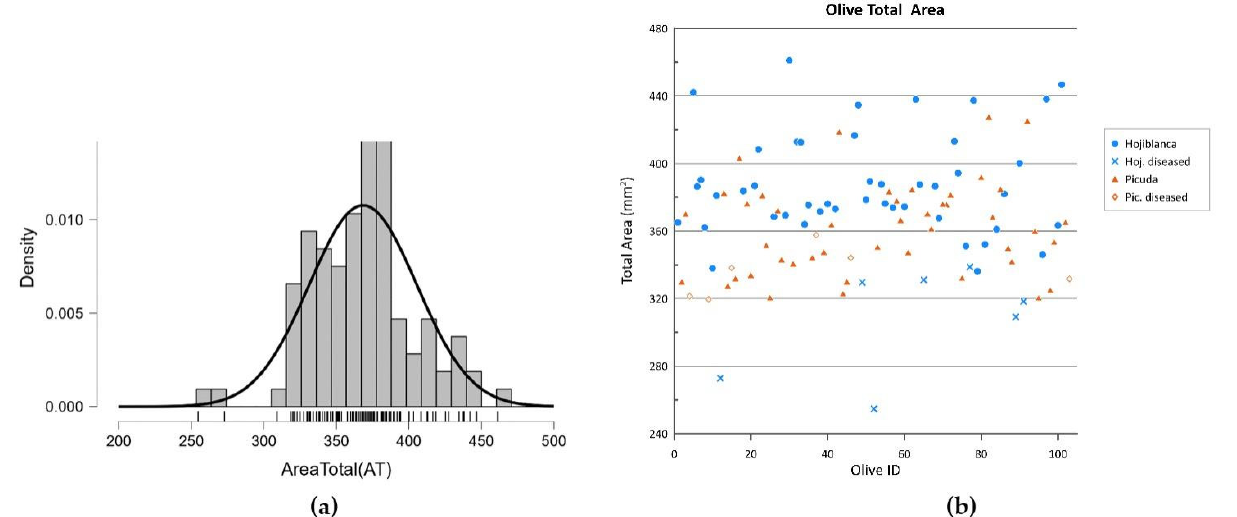
Figure 14. Total area distribution: ( a ) histogram vs. theoretical probability density function (PDF), ( b ) scatter plot.